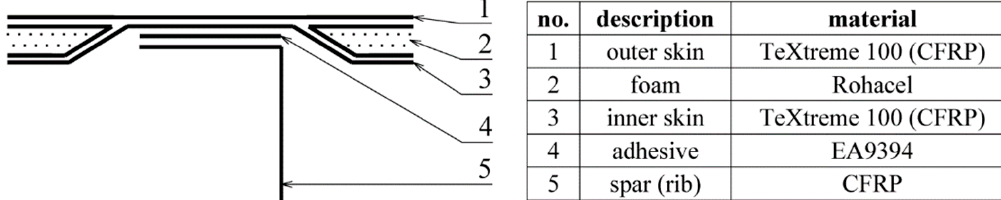
Figure 2. Bonded joint configuration.